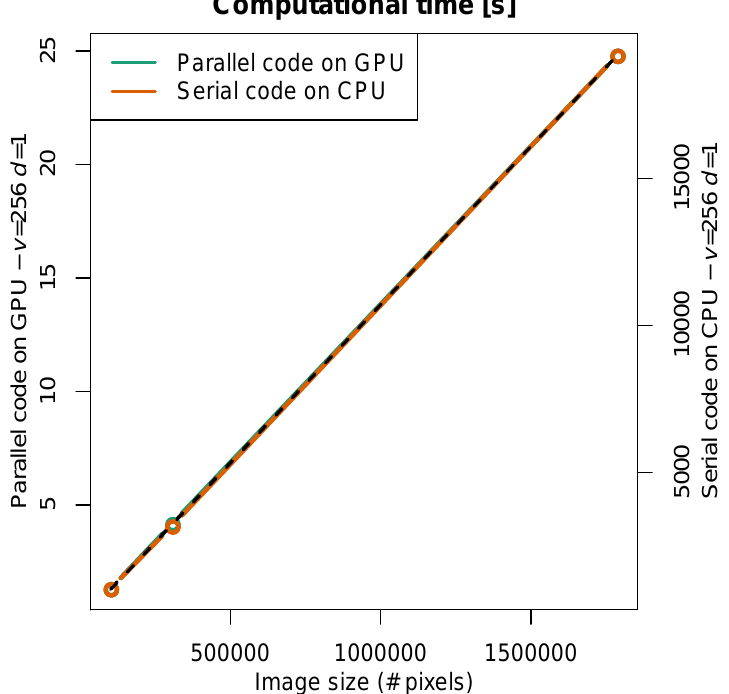
Figure 7. Plot computational time vs. size of the images (number of pixels) for 1 GPU unit and CPU architectures (case v = 8, d = 1). Corresponding regression fit is shown as black dashed